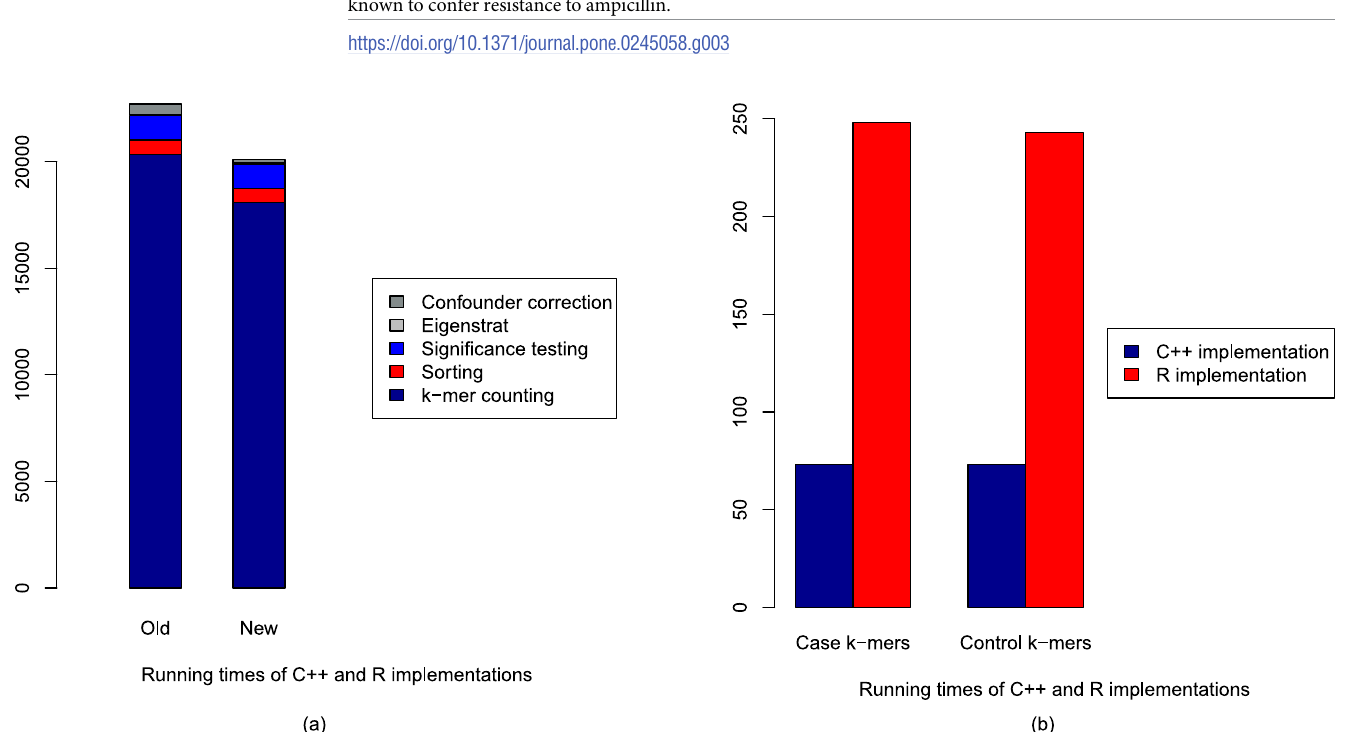
Fig 4. Comparison of execution times of old and new implementations (a) for the entire pipelines, and (b) correction of confounding factors using C++ and R implementations.